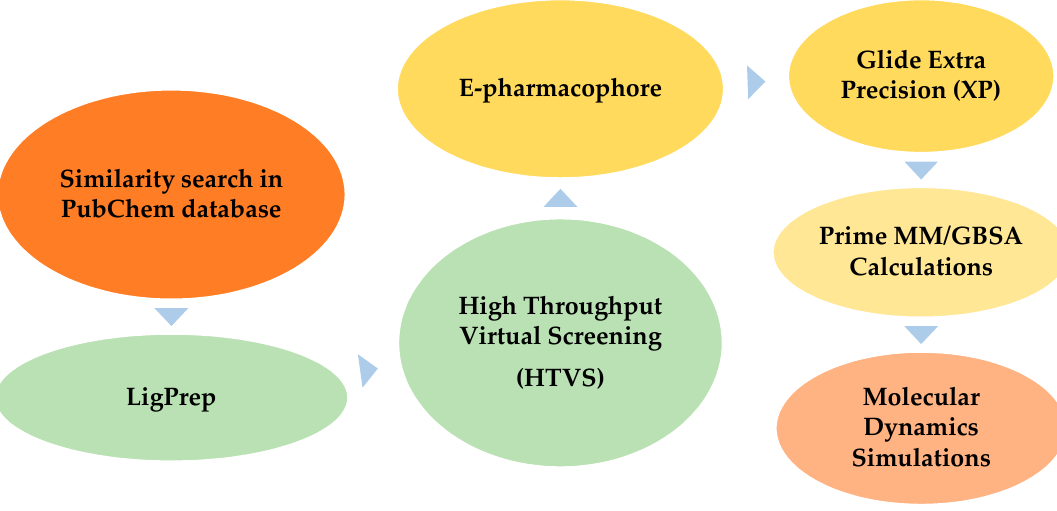
Figure 2. The flowchart of the virtual screening process.